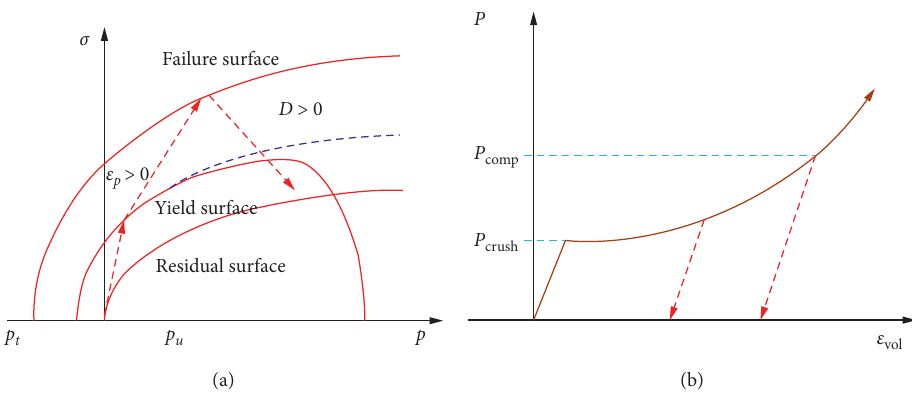
Figure 3: The RHT model. (a) Stress limit surfaces and loading scenario. (b) Schematic description of the P - α EOS